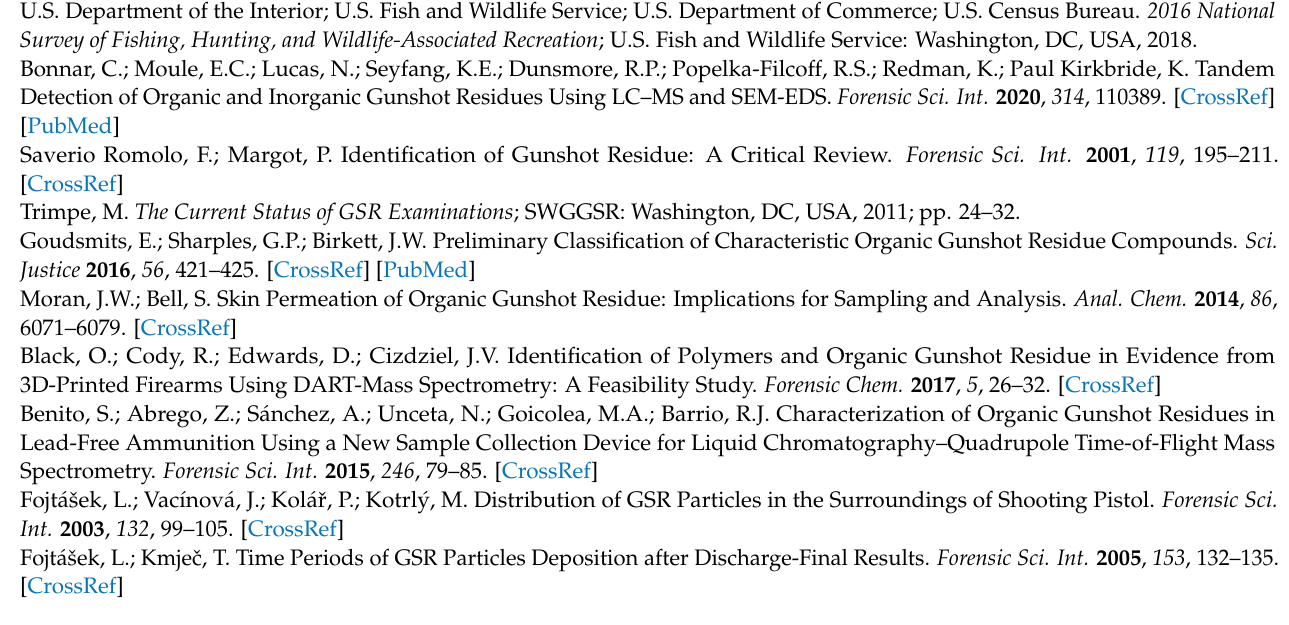
Table S2: Particle size distribution and zeta